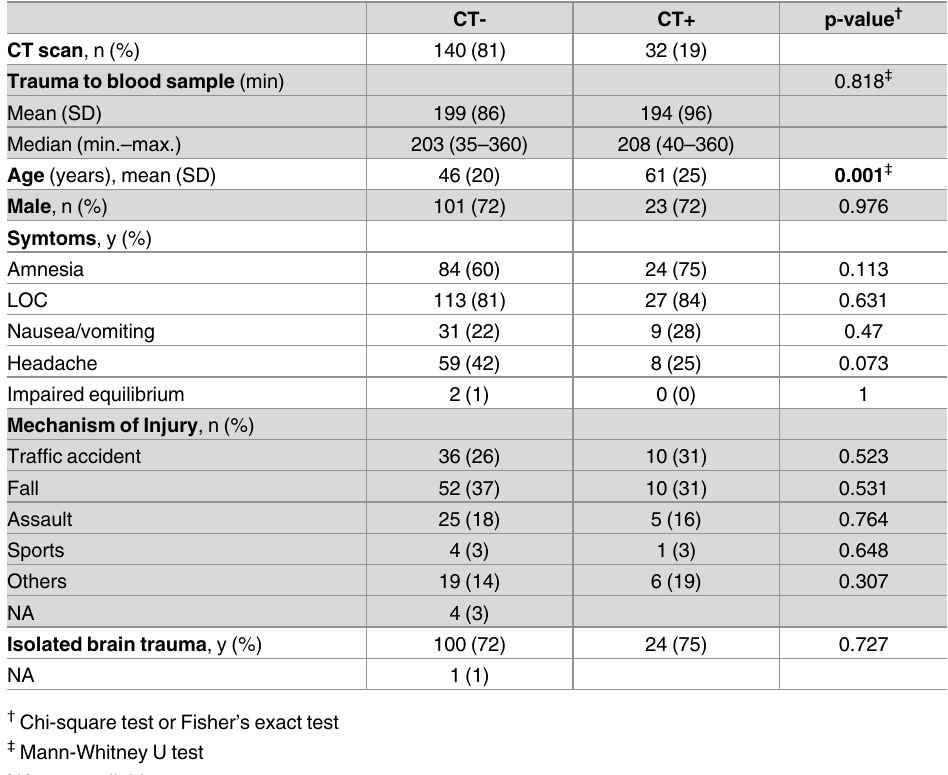
Table 1. Characteristics of mTBI patients, (cid:20) 6 h post-trauma.